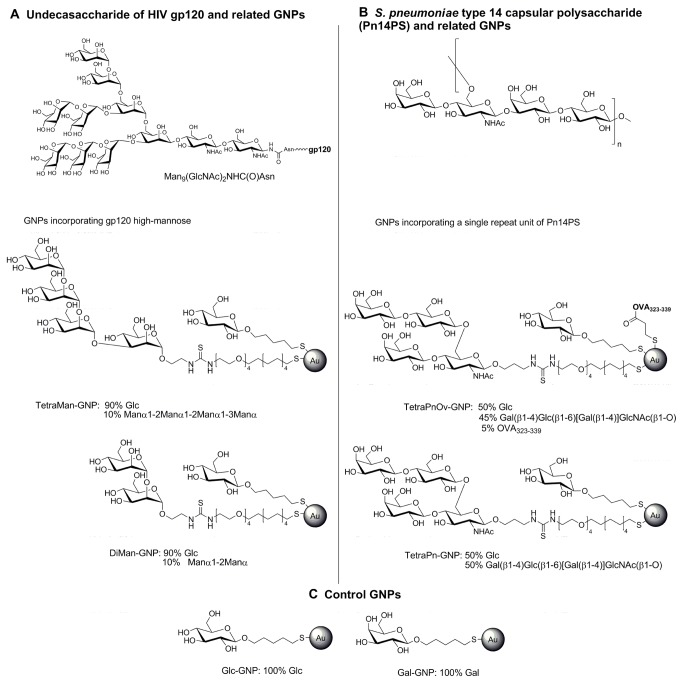
Gold glyconanoparticles used in this work to coat ELISA plates for anti-carbohydrate-antibodies detection.(A) High-mannose type undecasaccharide present on the HIV gp120 surface and GNPs carrying the tetramannoside (TetraMan) or dimannoside (DiMan), partial structures of the viral gp120 high-mannose undecasaccharide, to detect 2G12 antibody. (B) Repeating unit of S. pneumoniae type 14 capsular polysaccharide and GNPs carrying the tetrasaccharide epitope (TetraPn) of the S. pneumoniae Pn14PS and the T-helper OVA323-339. (C) GNPs carrying glucose or galactose as control.